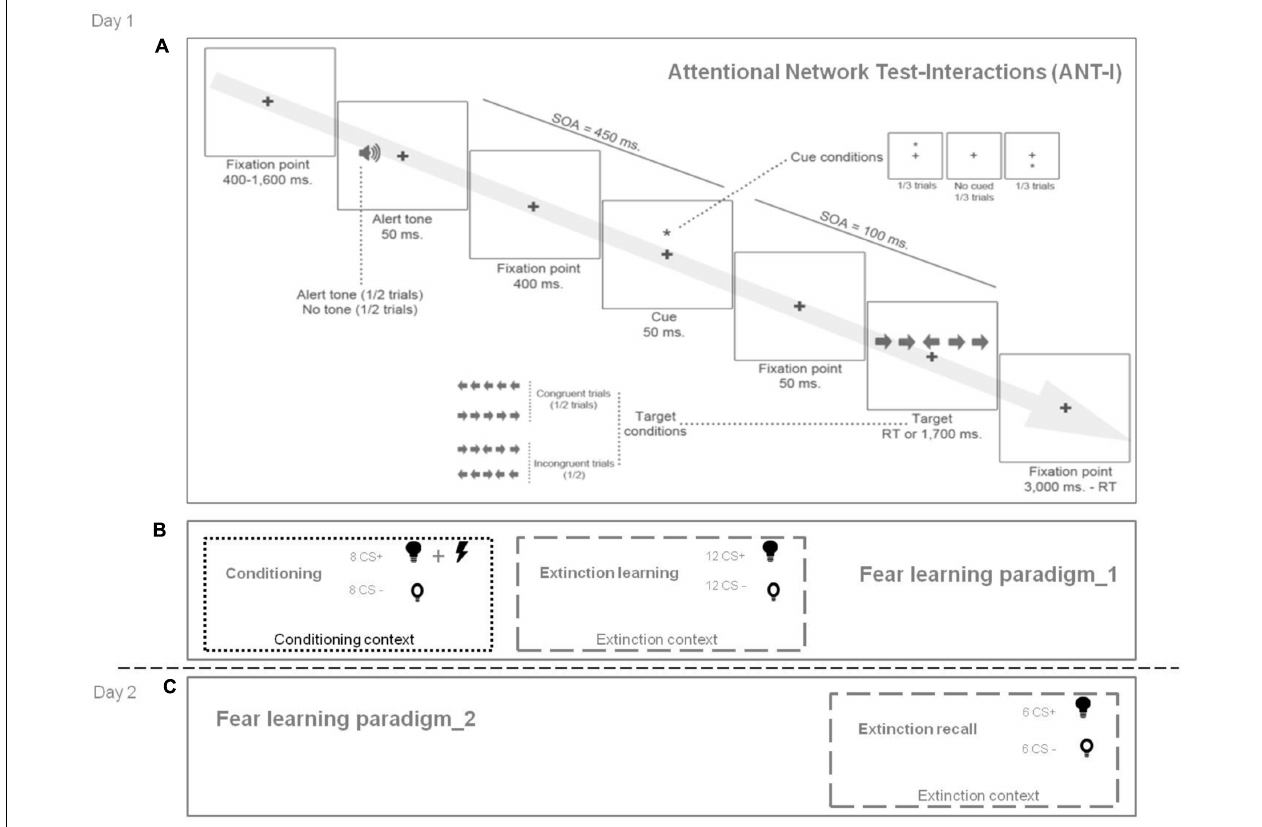
FIGURE 2 | Summary of experimental design. (A) Attentional Network Test-Interactions (ANT-I): Trials began with a fixation point (400–1600 ms). Then, in half of the trials, an alerting tone is presented (50 ms). In two-thirds of the trials, this is followed after 400 ms by an asterisk as an orienting signal (50 ms) either above or below the fixation point (cued trials). No asterisk is presented in the remaining third of the trials (uncued condition). Then, the asterisk disappears leaving only the fixation point. After 50 ms, an arrow flanked by four distractor arrows (two on each side) is presented. The distractors point either in the same direction as the arrow target (i.e., congruent trials) or in the opposite direction (i.e., incongruent trials), and in the same position as the orienting cue (i.e., valid trials) or at the opposite location (i.e., invalid trials). Participants have to indicate the direction in which the target was pointing (right or left). After the response, the fixation point is presented for up